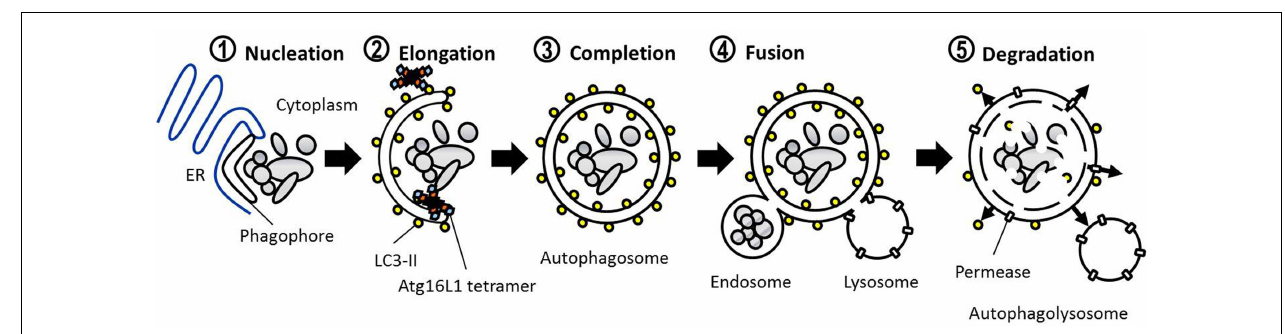
FIGURE 1 | Basic steps involved in mammalian